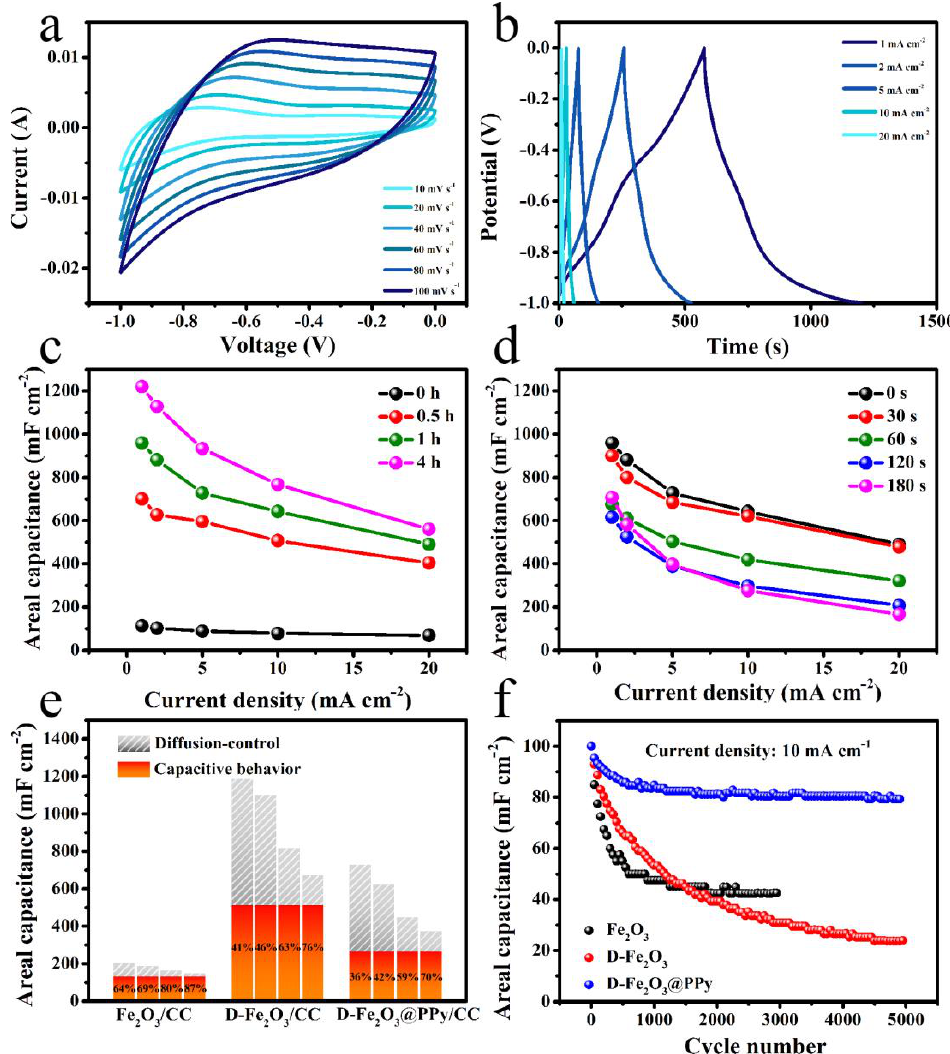
Figure 5. ( a ) CV curves of D-Fe 2 O 3 @PPy/CC (D-Fe 2 O 3 @PPy-120 s) at different scan rates. ( b ) GCD curves of D-Fe 2 O 3 @PPy/CC (D-Fe 2 O 3 @PPy-120 s) at different current densities. ( c ) Rate perfor- mances of D-Fe 2 O 3 /CC electrodes. ( d ) Rate performances of D-Fe 2 O 3 @PPy/CC electrodes. ( e ) Diffu- sion and capacitive contributions of Fe 2 O 3 /CC, D-Fe 2 O 3 /CC (D-Fe 2 O 3 -1 h), and D-Fe 2 O 3 @PPy/CC (D-Fe 2 O 3 @PPy-120 s) electrodes at scan rates of 10, 20, 60, 100 mV s − 1 . ( f ) Long-cycling performances at current density of 10 mA cm − 1 for 5000